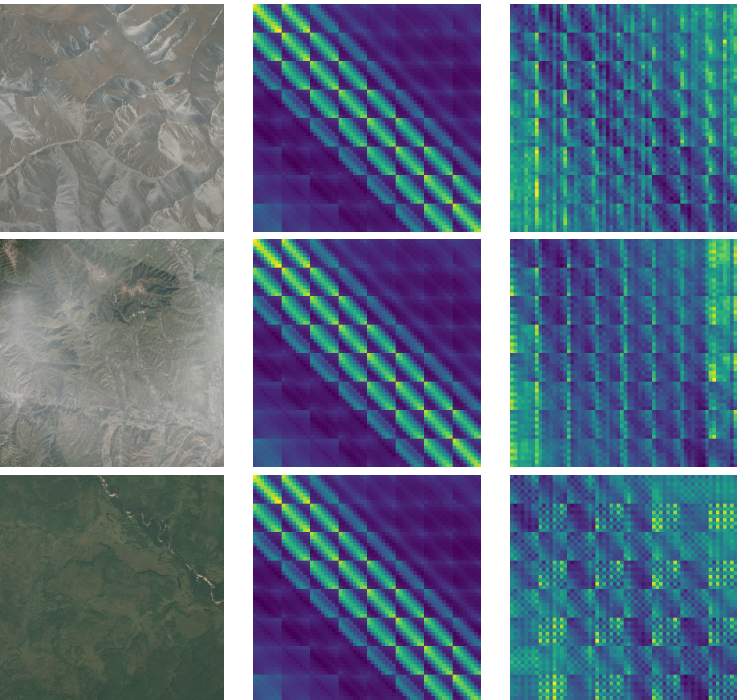
Figure 2. Visualization of self-attention weights for the 1st and 10th blocks in the network. The first column represents the input cloud-contaminated image. The second column represents the heatmaps corresponding to the average self-attention weight of all windows in the 1st block. The third column represents the heatmaps corresponding to the average self-attention weight of all windows in the 10th block. It can be seen from the figure that the heatmaps present a diagonal distribution in the shallow layer of the network, which indicates that the self-attention weight is mainly generated in the neighborhood of tokens. In contrast, in the deeper layers of the network, the heatmaps are uniformly distributed, which indicates that the self-attention mechanism is effective in the entire